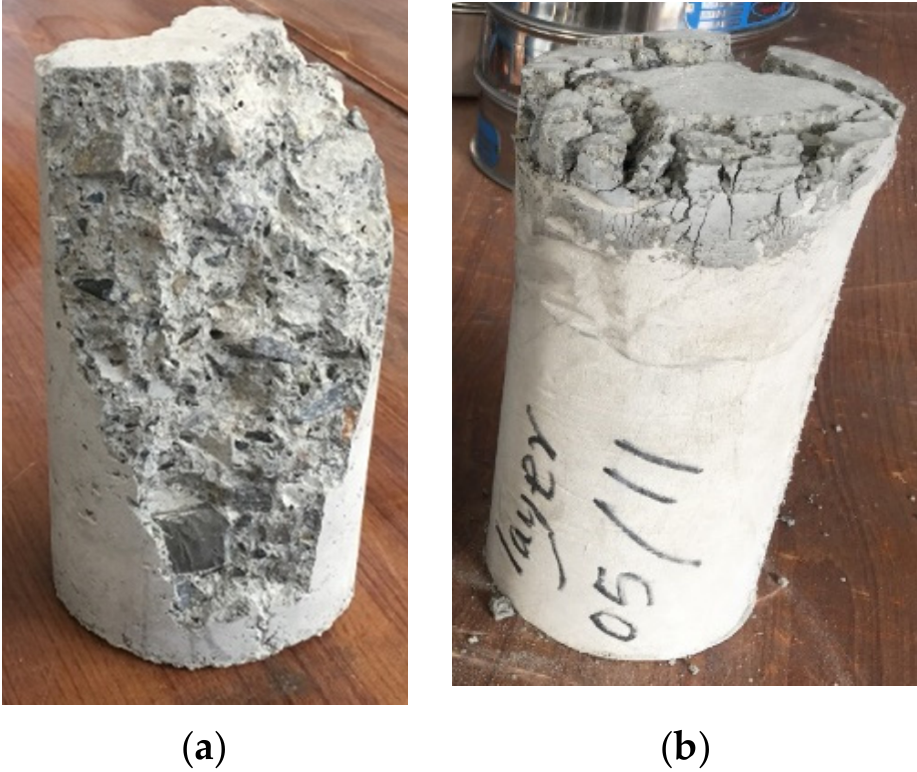
Figure 6. Cracking mechanism of cylinders. ( a ) Reference and ( b ) covered samples .